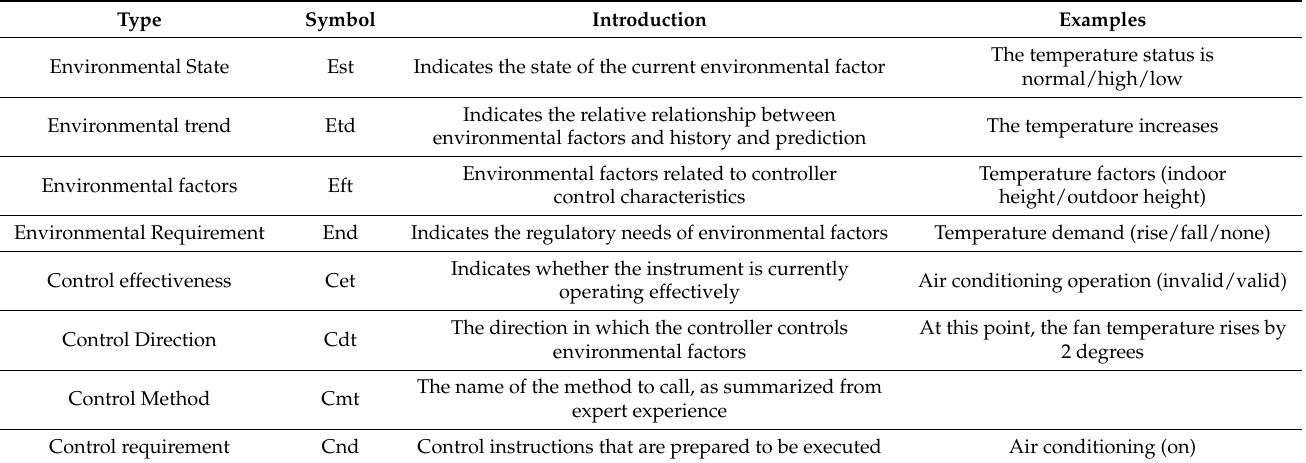
Table 2. Intermediate information table.